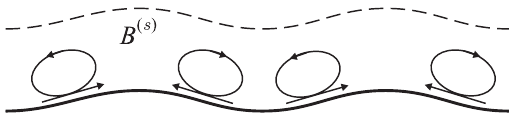
Fig. 3 Sketch of mean flow (secondary flow of Prandtl’s second kind) near the undulatory